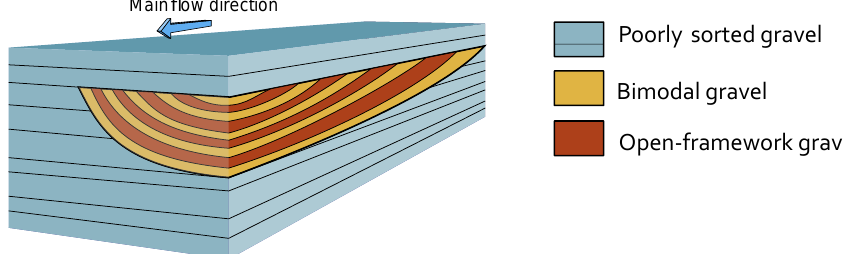
Figure 1. Simplified conceptual model of a single trough fill (with alternating open-framework–bimodal gravel couplets) embedded into layers of poorly sorted gravel. Table 1. Hydraulic properties of the main sedimentary structures (after Jussel et al., 1994a). Poorly sorted gravel